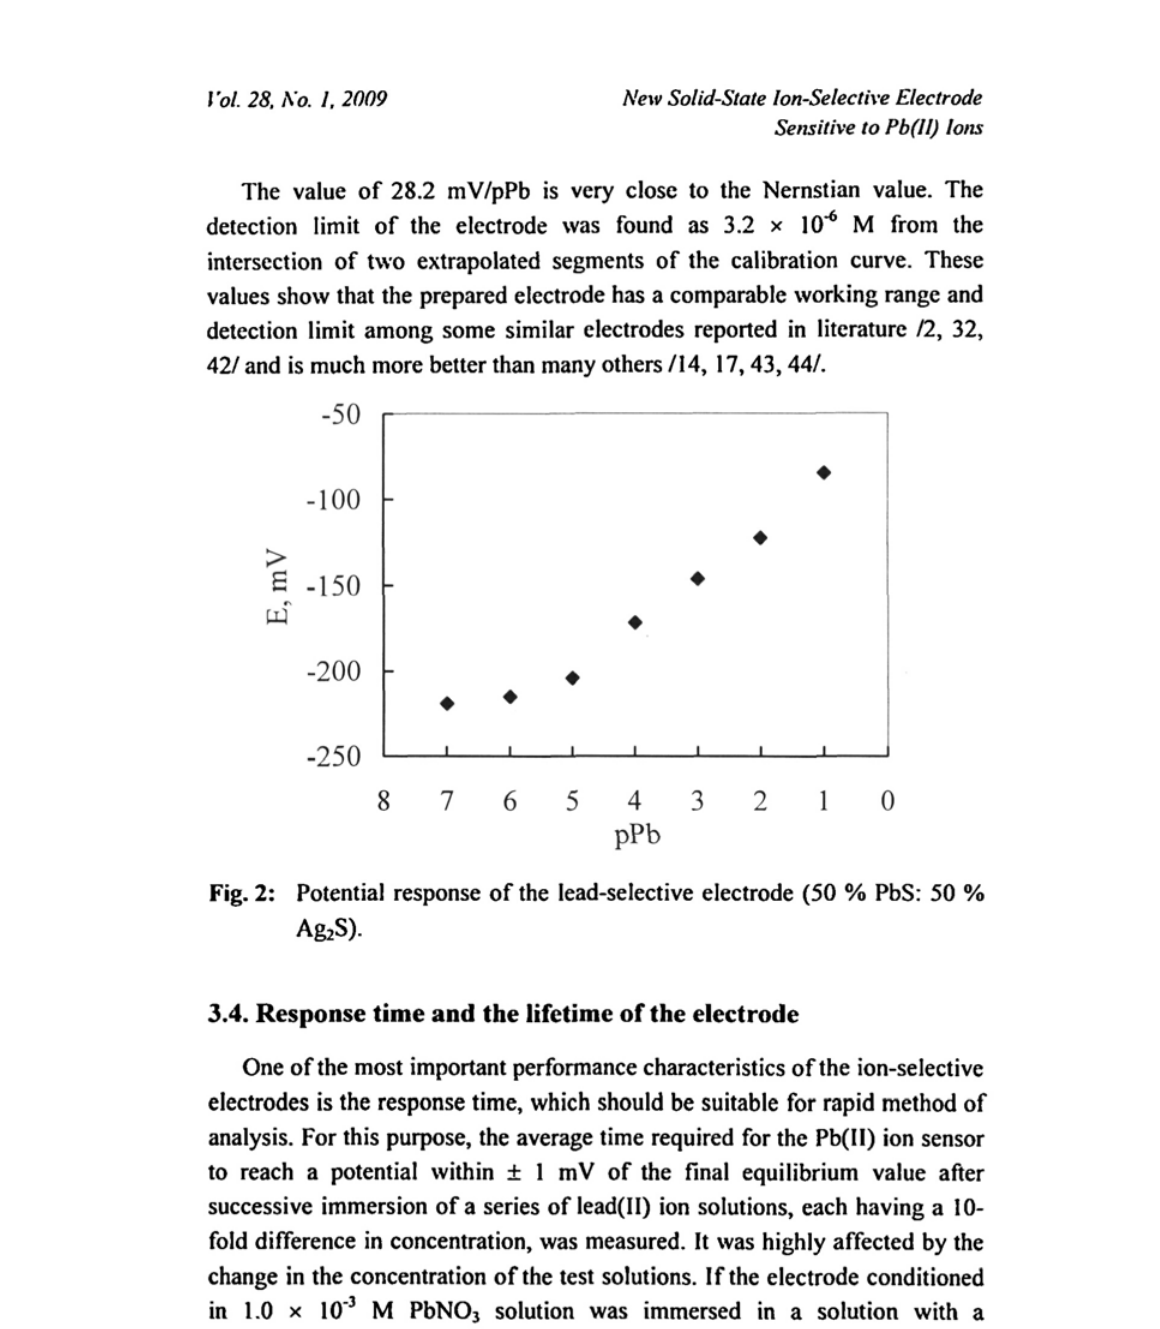
Fig. 2: Potential response of the lead-selective electrode (50 % PbS: 50 % Ag 2